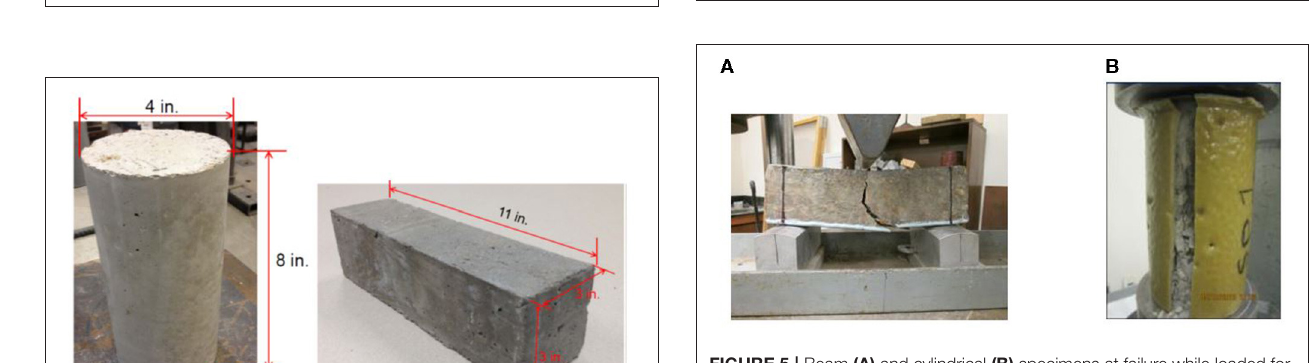
FIGURE 5 | Beam (A) and cylindrical (B) specimens at failure while loaded for flexural and compressive strength,